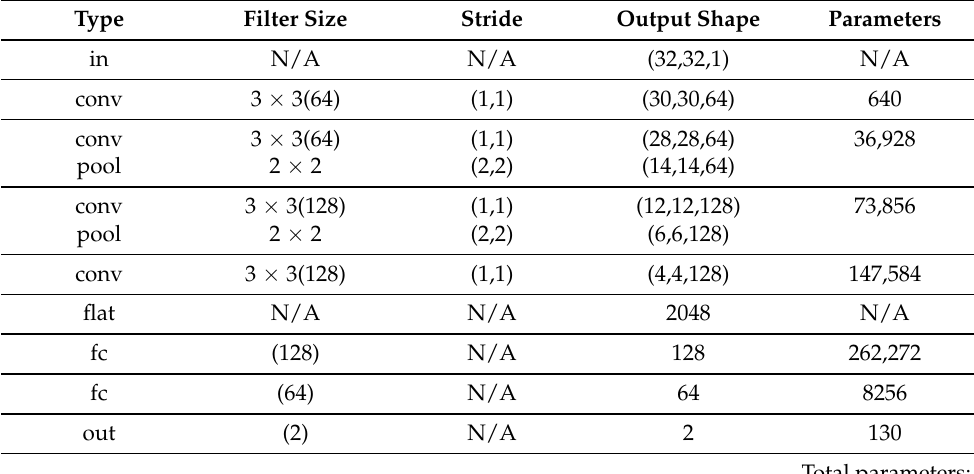
Table 1. The detailed information of CNN model in this